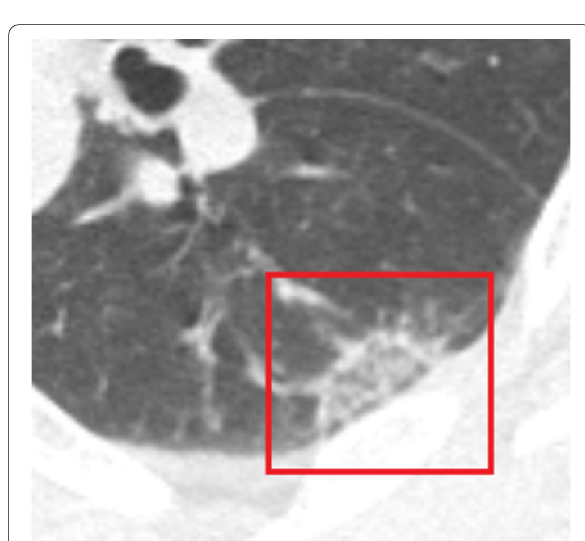
Fig. 3 A 73-year-old man in the non-COPD group. Axial CT image (region of interest), demonstrates “reversed halo” sign (red frame). COPD—chronic obstructive pulmonary disease; CT—computed